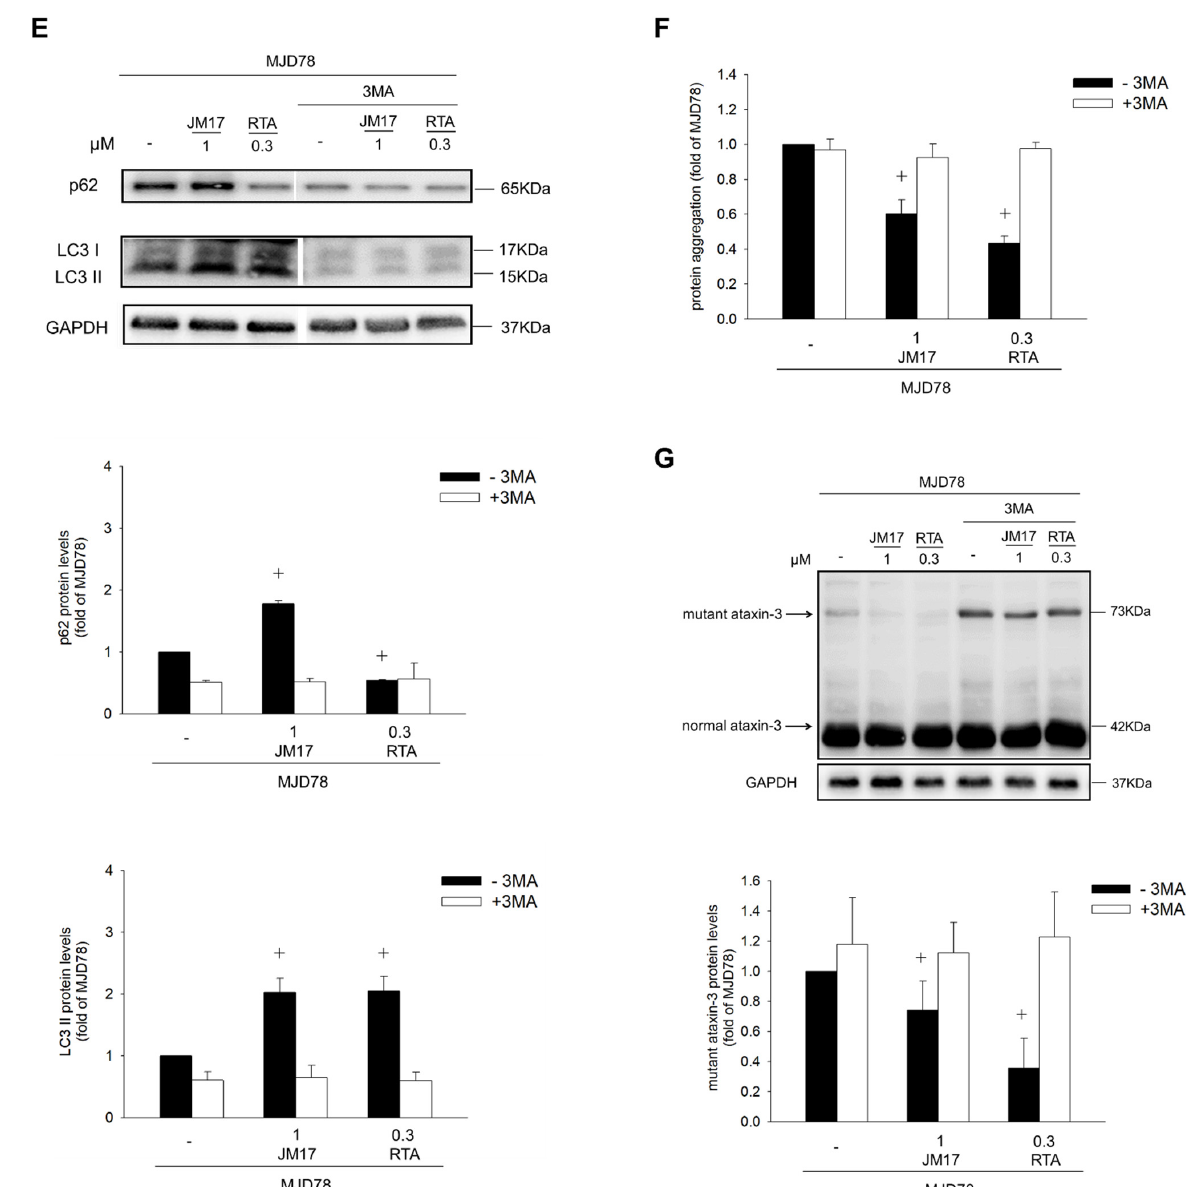
Figure 2. Induction of autophagy-mediated degradation of polyQ mutant ataxin-3 expression and decrease in protein aggregation. Cells were treated with or without DMSO vehicle control or with 0.3, 1, or 5 μ M JM17, 0.3 μ M RTA-408, or 10 μ M DMF for 24 h. ( A ) The mRNA level of ATXN3 was detected by using quantitative real-time RT–PCR analysis. The ATXN3 mRNA expression was quantified by normalized β -actin. ( B ) Protein aggregation was assessed using the PROTEOSTAT ® protein aggregation assay. ( C ) Protein expression of mutant and normal ataxin3. ( D ) Protein expression of p62 and LC3-II. Cells were treated with or without DMSO vehicle control or with 1 μ M JM17 or 0.3 μ M RTA-408 for 24 h in the absence or presence of pretreatment with 1 mM 3MA for 1 h. ( E ) Protein expression of p62 and LC3-II, ( F ) protein aggregation, and ( G ) protein expression of mutant and normal ataxin3 in 3MA treatment. Data are presented as the mean ±SD of at least three independent experiments. Values from the treated cells were normalized to those of the MJD78 cells treated with vehicle only. In 3MA treatment graphs, within treatments with the same absence or presence of 3MA, values are expressed as the percentage of MJD78 cells treated with vehicle only. * p < 0.05, compared to non-treated MJD78 group; # p < 0.05, compared to MJD26 group; + p < 0.05, compared to non-treated MJD78 with absence of 3MA group.